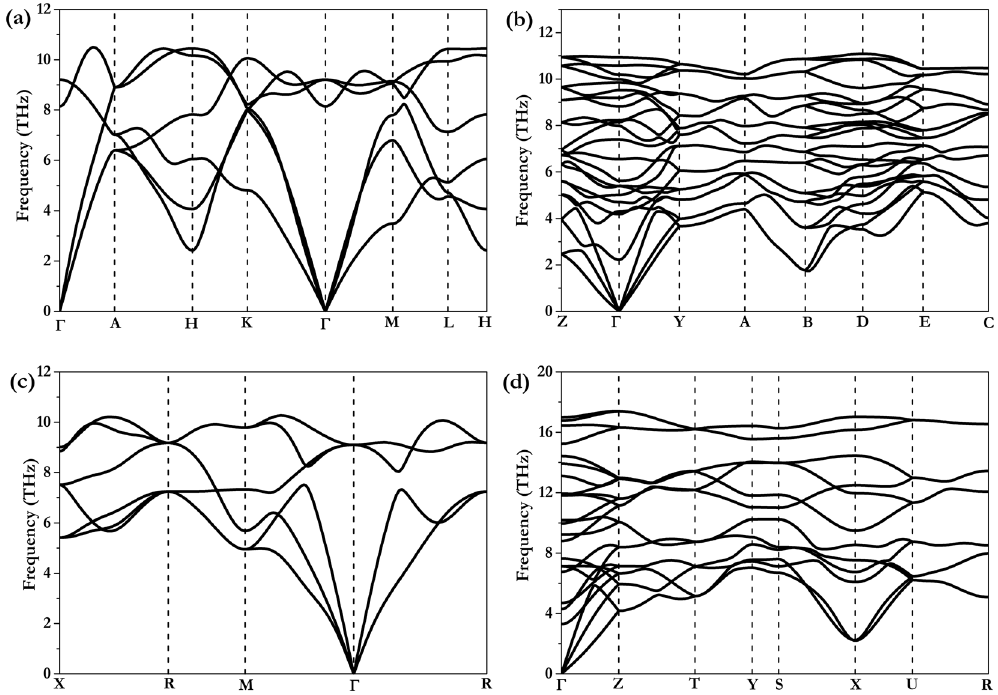
Figure 3. Phonon dispersions of NbAs and NbP. (a) P -6m2 structure of NbAs at 30 GPa, (b) P 2 1 /c structure of NbAs at 50 GPa, (c) P m-3m structure of NbAs at 80 GPa, and (d) C mcm structure of NbP at 80